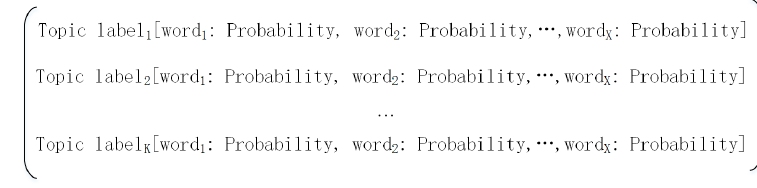
Figure 5. The format of topic distribution after dimension reduction.